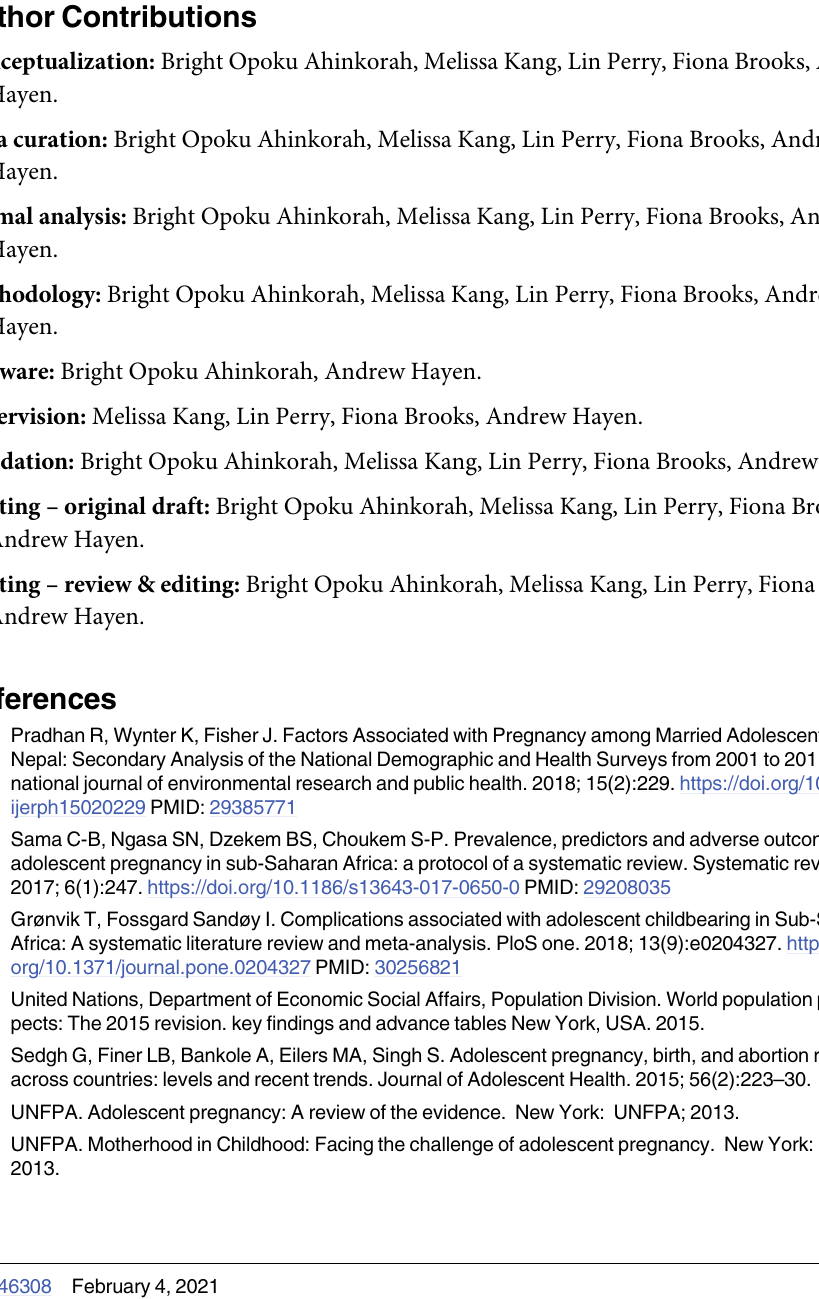
S1 Table. Description of the study